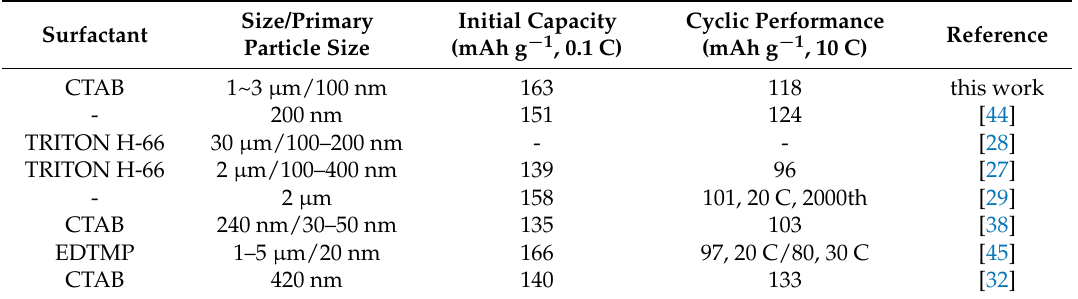
Table 1. Comparison of hollow spherical LiFePO 4 composites reported